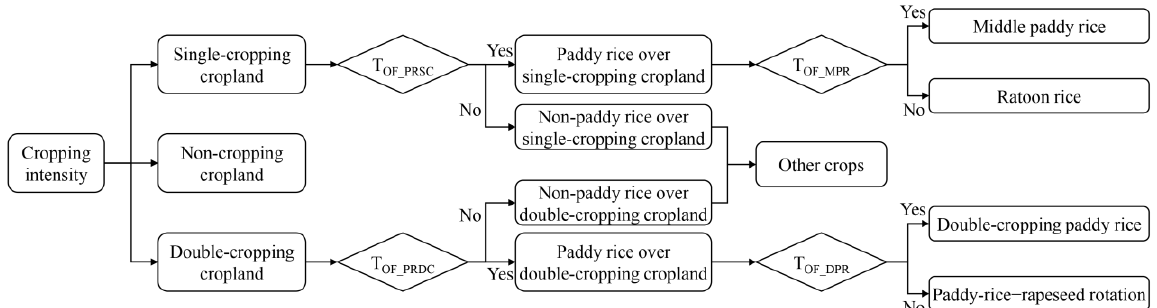
Figure 4. The developed DT model for identifying each PRCP based on three hierarchical levels. “T OF_PRSC ” and “T OF_PRDC ” denotes the threshold of optimal features for identifying paddy rice over single- and double-cropping cropland, respectively, whereas “T OF_MPR ” and “T OF_DPR ” indicates the threshold of optimal features for identifying middle and double-cropping paddy rice, respectively.